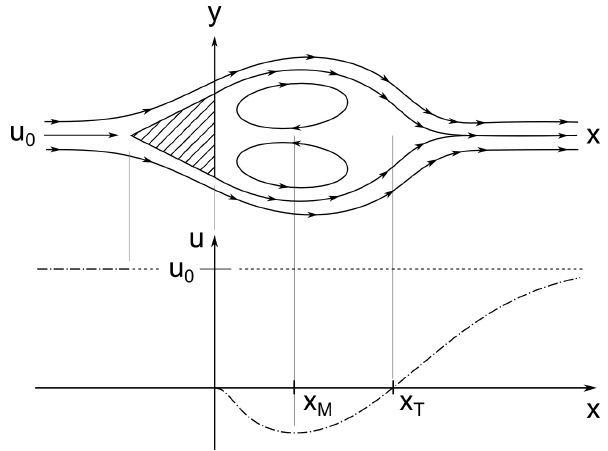
Figure 1. Schematic representation of fluid flow past a triangular bluff body at medium Reynolds numbers, causing Föppl vortices and the resulting total flow velocity along the symmetry